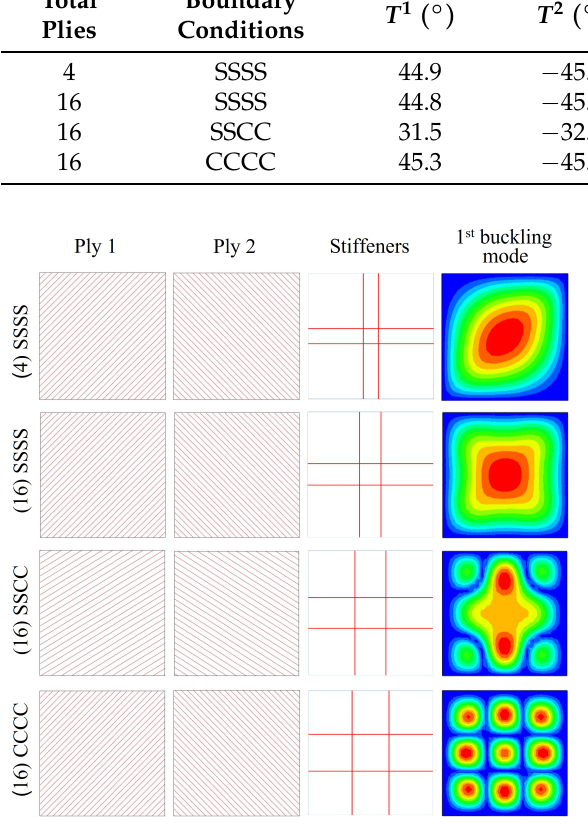
Figure 10. Optimized straight fiber panels subjected to biaxial